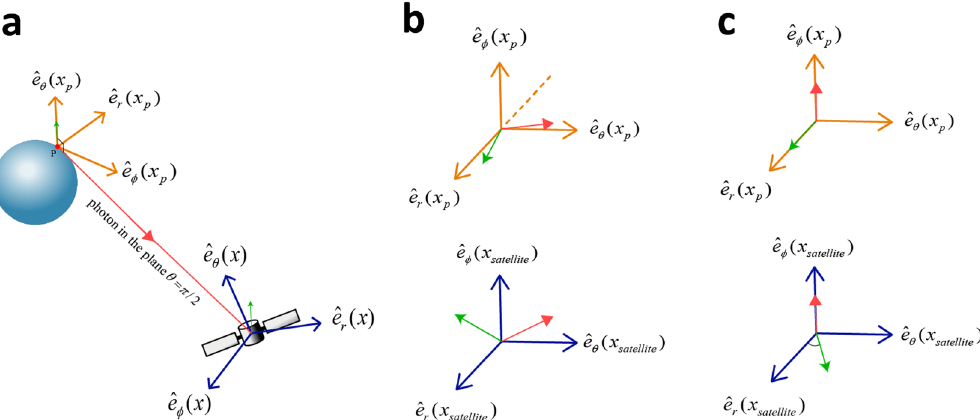
Fig. 1 Schematics of the Earth-satellite system. The Earth-Satellite system and corresponding coordinates. a A photon ’ s geodesic and its polarizations are represented by a red line and light-green arrows, respectively. b , c The wave vector and polarization of the photon are measured in each local frame ( b ) and compared in the standard frame ( c